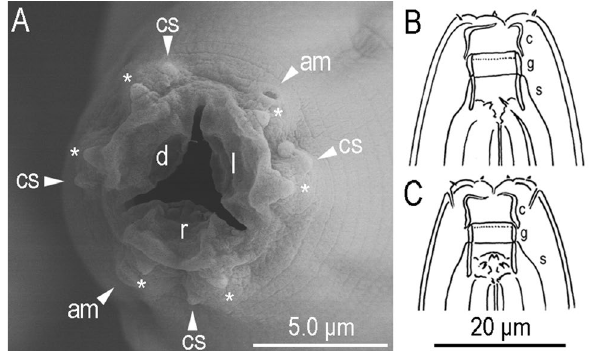
Figure 1. Stomatal structure of Caenorhabditis auriculariae . ( A ) En face view where lavial censilla (asterisk), cephalic sensilla (c), amphids (a) and cheilostomatal flap baring on dorsal (d), right subventral (r) and left subventral (l) sectors are suggested; ( B ) left lateral view; ( C ) ventral view. Cheilostom (c), gymnostom (g) and stegostom (s) are suggested in ( B , C